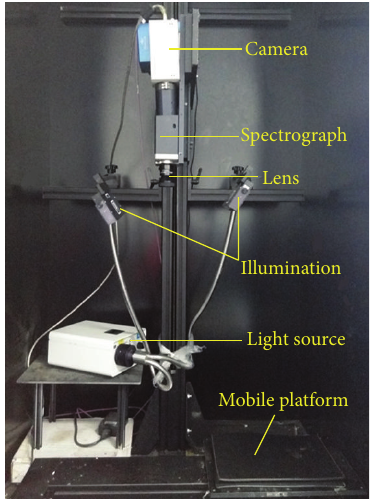
Figure 1: Schematic diagram of the main components of the hyper- spectral